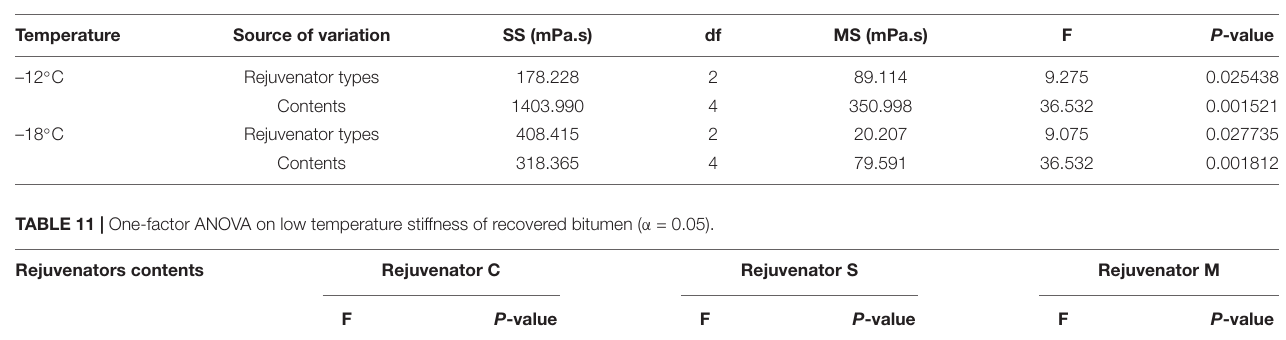
FIGURE 9 | Low temperature stiffness on recovered bitumen at –12 and –18 ◦ C. (A) Temperature at –12 ◦ C. (B) Temperature at –18 ◦ C. TABLE 10 | Two-factor ANOVA on the low temperature stiffness of recovered bitumen ( α = 0.05).